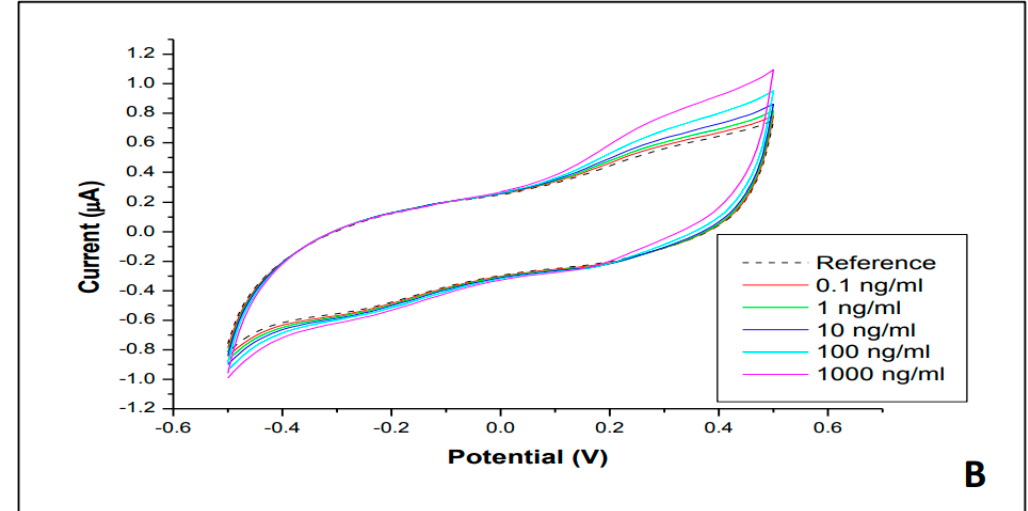
Figure 2. Cyclic voltammograms of screen-printed electrodes with immobilized anti Hg 2 + ( A ) and anti-Pb 2+ ( B ) aptamers in HBB solutions with different concentrations of HgCl 2 and PbCl 2 salts. The reference curves were recorded in pure HBB without heavy metal salts added.